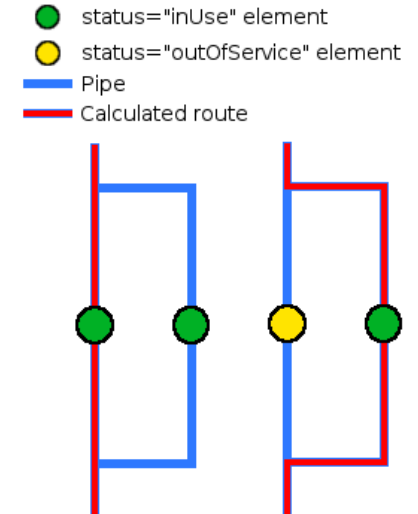
Figure 5. Different routing results obtained when switching an element’s “status”